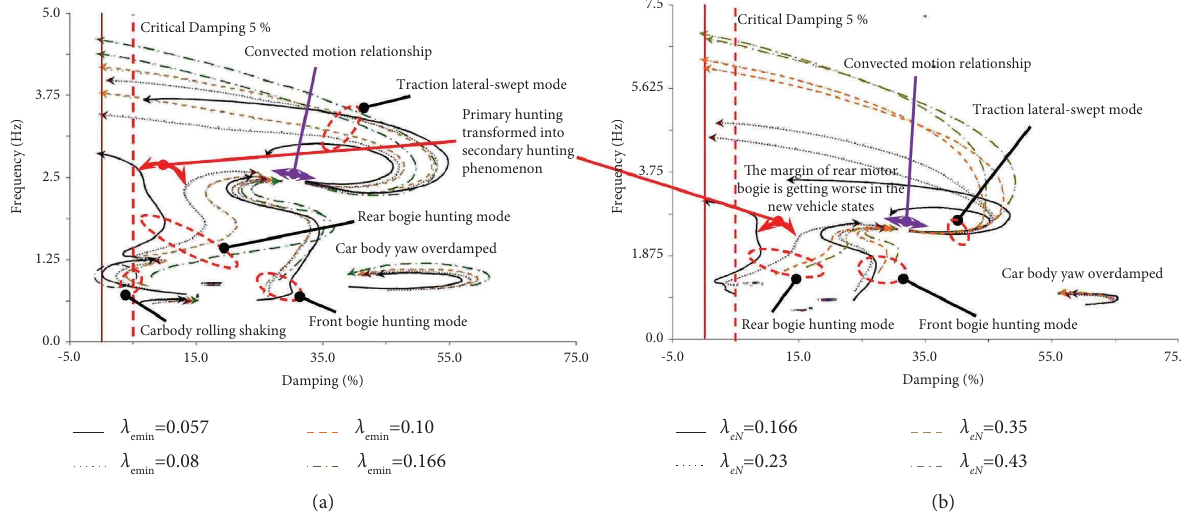
Figure 2: Primary hunting phenomenon occurred in German ICE3 serial bogies with ZF Sachs T60/T70 confgurations. (a) Under ZF Sachs T60 original confguration with end-joint stifness 70MN/m. (b) Under ZF Sachs T70, the improved confguration with end-joint stifness of